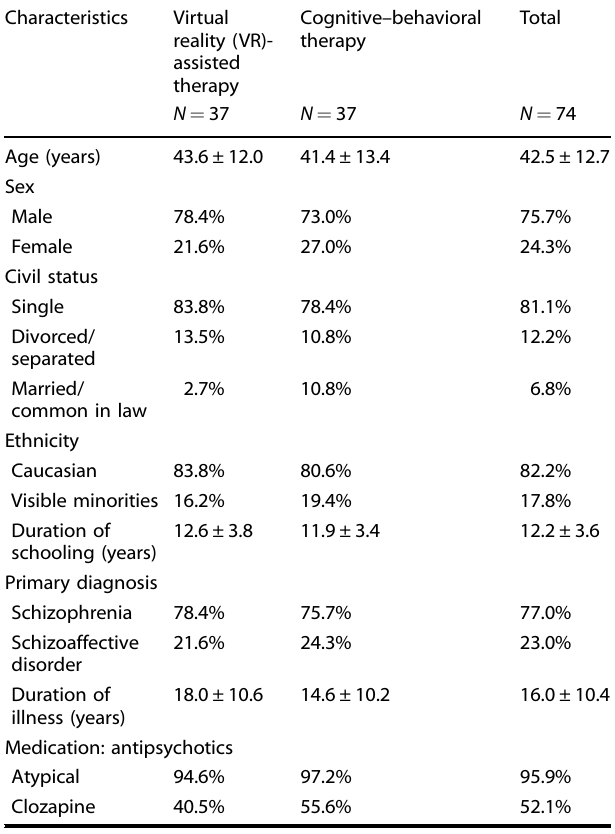
Table 1. Baseline sociodemographic and clinical